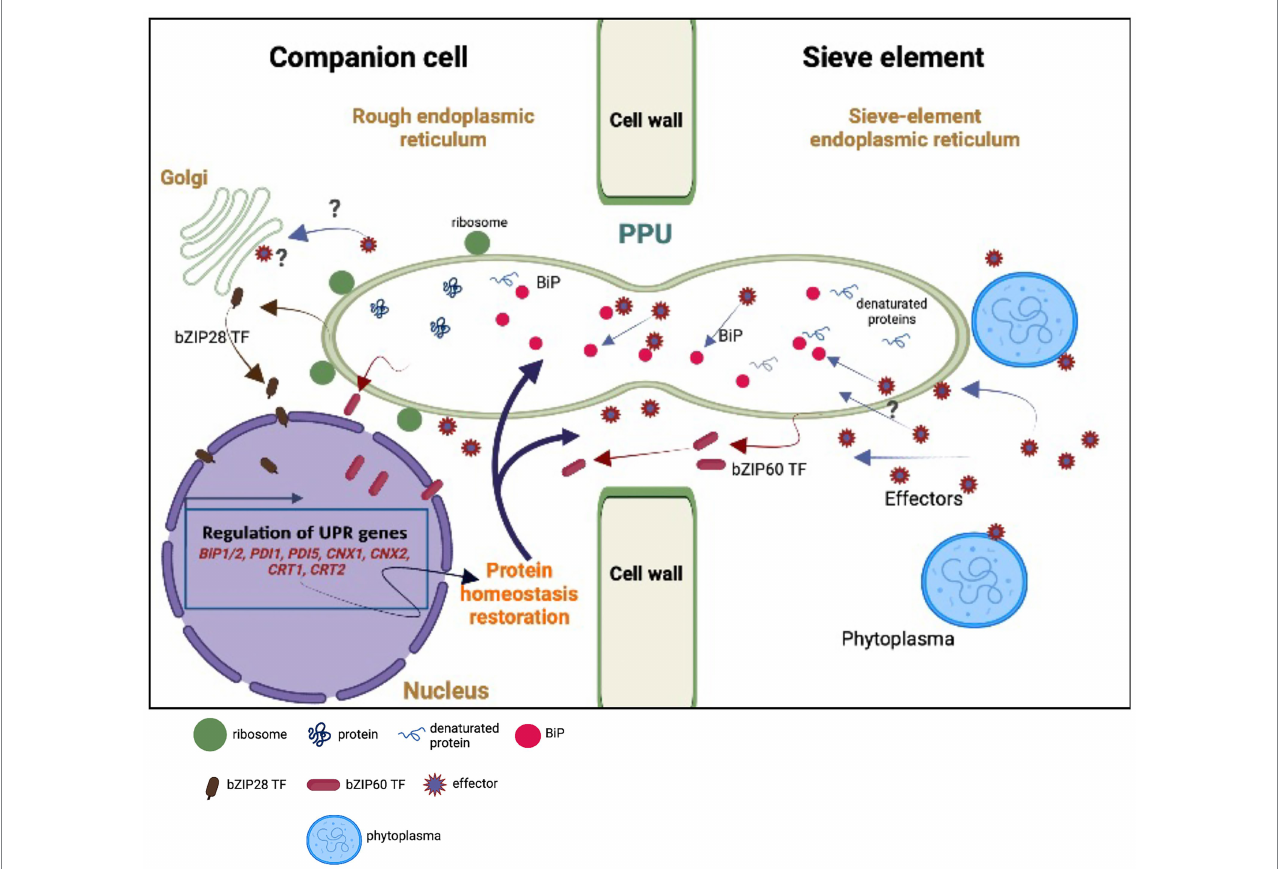
FIGURE 5 Model of hypothetical unfolded protein response (UPR) as the result of an interplay between the sieve element (SE) and the companion cell (CC). Upon perception of phytoplasma effectors, the sieve-element endoplasmic reticulum (SE-ER) is subject to stress (Buxa et al., 2015; Breeze et al., 2020) so that the number of misfolded proteins is rising due to the cleavage of BiPs. Stress sensing extends to the rough endoplasmic reticulum (r-ER) in the SE-adjacent cells (CCs, in particular) due to the effect of phytoplasma effectors (Bai et al., 2009) moving via cytosolic channels and/or r-ER/SE-ER connections in the pore-plasmodesma units (PPUs). Effectors are responsible for increased misfolding of proteins (Celli and Tsolis, 2015) and for the cleavage of BiPs, provoking the release of bZIP60 and bZIP28 transcription factors (TFs) in SEs and CCs. Local cleavage of BiPs in the SE-ER may confer diffusional withdrawal of BiPs from the r-ER in CCs via the connections between SE and SE-ER inside the PPUs. The question marks indicate uncertainties or missing knowledge on the putative events. The modified expression levels of the UPR-related genes must rely on the activities of the nucleate CCs or phloem parenchyma cells (PPCs; van Bel and Musetti, 2019) and UPR-associated proteins may traffic from the CCs to the SEs via both the r-ER-connections and the cytoplasmic corridors within the PPUs. For reasons of clarity, the structure of the PPUs does not represent the actual situation, in which the PPUs are branched at the